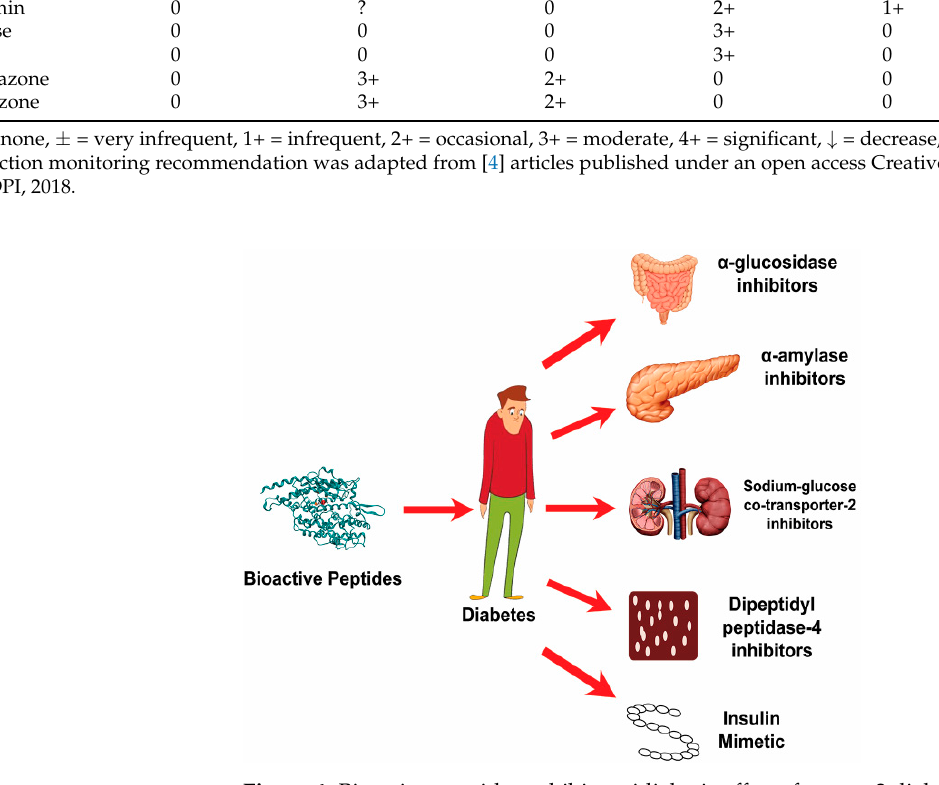
Figure 4. Bioactive peptides exhibit antidiabetic effects for type 2 diabetes mellitus based on inhibi- tion against α - amylase, α -glucosidase, sodium glucose co-transporter-2 inhibitors, plasma-based dipeptidyl peptidase-4 (DPP4) inhibitors (an obesity-independent parameter for glycaemic dereg- ulation in type 2 diabetes patients), and insulin mimetic (which promote the glucose entry into the tissues, whereas the glucose either be converted into energy or stored for later use),